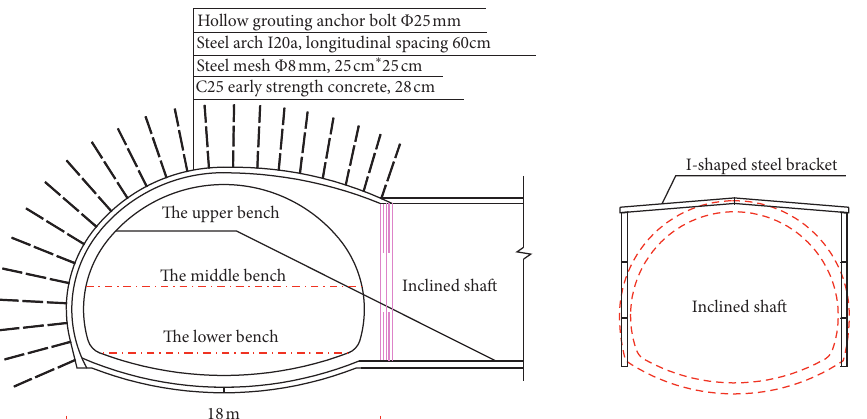
Figure 4: Original support design of intersection.